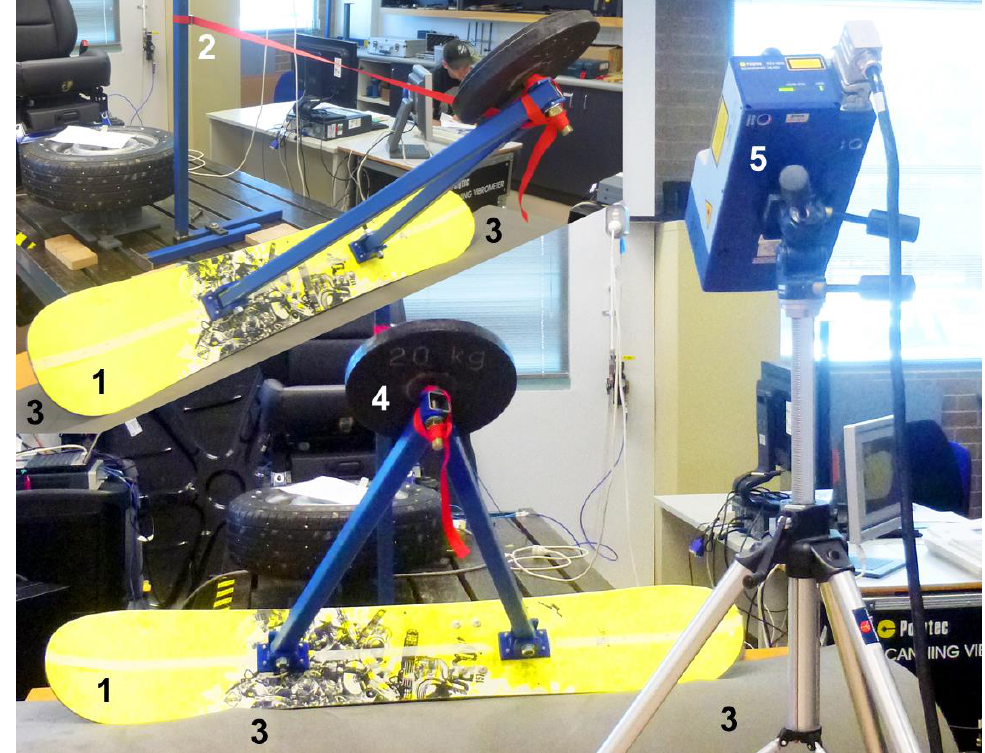
Figure 3. Test set-up of the tilted and loaded board; 1: board B; 2: inelastic belt tying the frame of the board to a post; 3: foam surface; 4: added load of 20 kg; 5: head of laser scanner. Two snowboard decks, Salomon Prospect 160 (board A) and Rossignol Decoy 157 (board B), were tested five times at each inclination angle. The edge of the boards was placed on an elastic closed-cell polyurethane foam mat, characterized by the following parameters: density: 34 kg/m 3 ; thickness: 20 mm; compressive stress: 240 kPa at 0.5 strain (ASTM D3574 C). The surface was smooth, formed by the tough outer skin of the foam. The surface was selected from the following criteria: the board’s edge had to indent the surface to be kept in place and simultaneously allow sufficient movement to be measured by the laser vibrometer.